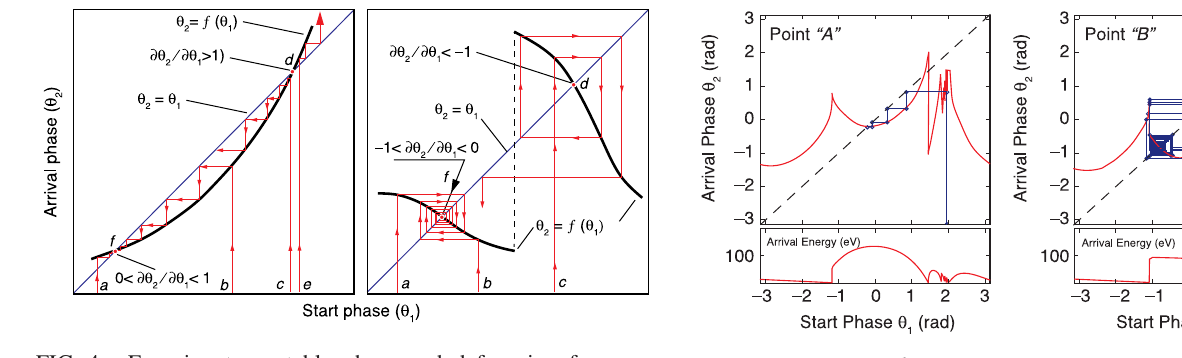
FIG. 4. Focusing to a stable phase and defocusing from an unstable phase for an increasing and a decreasing function.